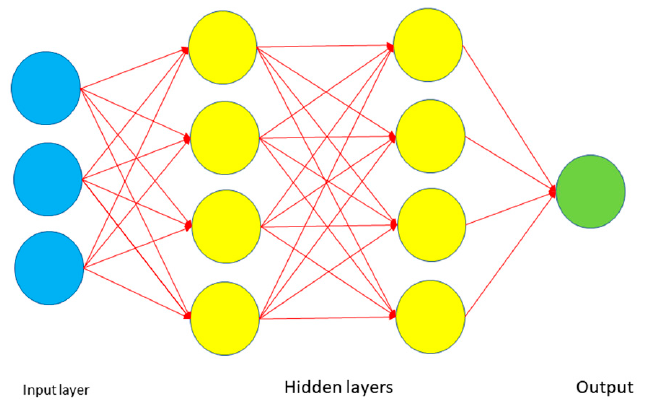
Figure 4. General architecture of an ANN.